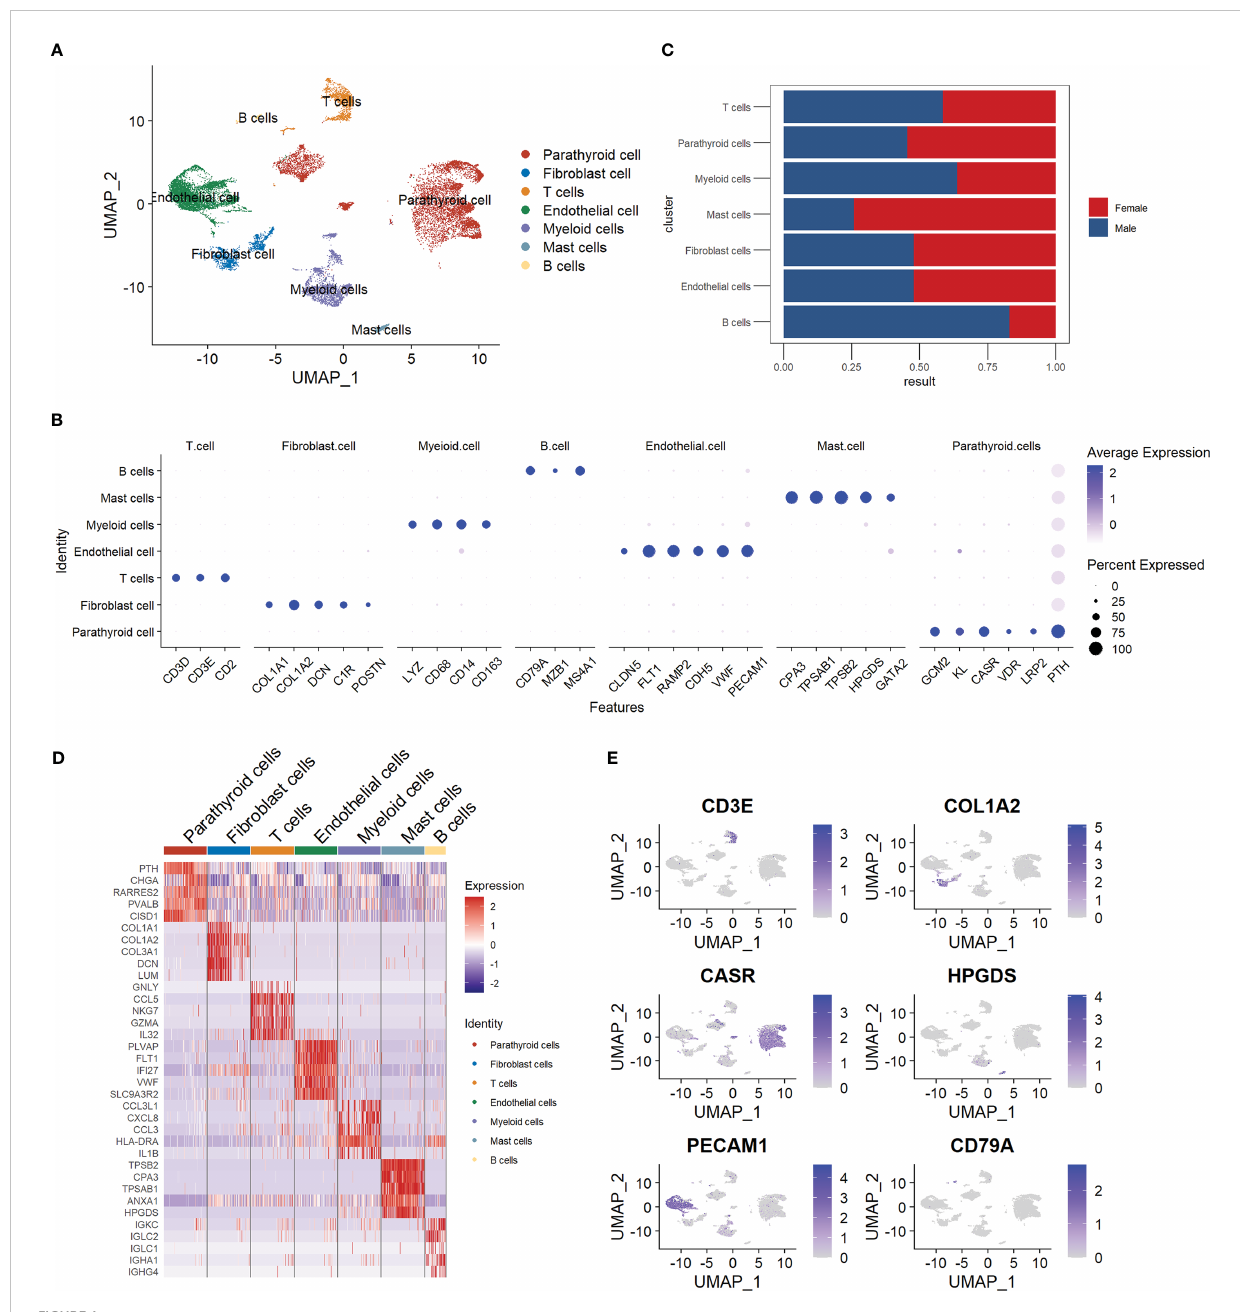
FIGURE 1 Summary of cell composition in PHPT patient samples. (A) Umap visualization of the seven manually annotated cell populations. (B) Dot plot of representative cell markers of each cell type. (C) Cell proportion comparison between male and female patient samples. (D) Heatmap of top fi ve markers of each cell type. (E) Feature plot of representative cell markers of each annotated cell